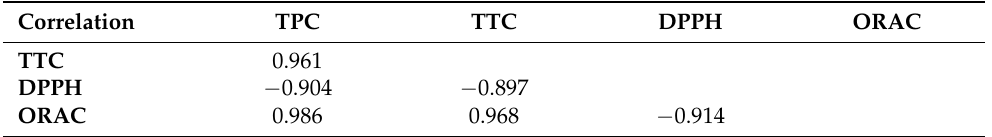
Table 4. Pearson coefficient correlations between TPC, TTC, and antioxidant activity (DPPH and ORAC) of extracts obtained from different wine lees using 50% acidified solvent of ethanol (1% HCl). Correlation TPC TTC DPPH ORAC TTC 0.961 DPPH − 0.904 − 0.897 ORAC 0.986 0.968 − 0.914